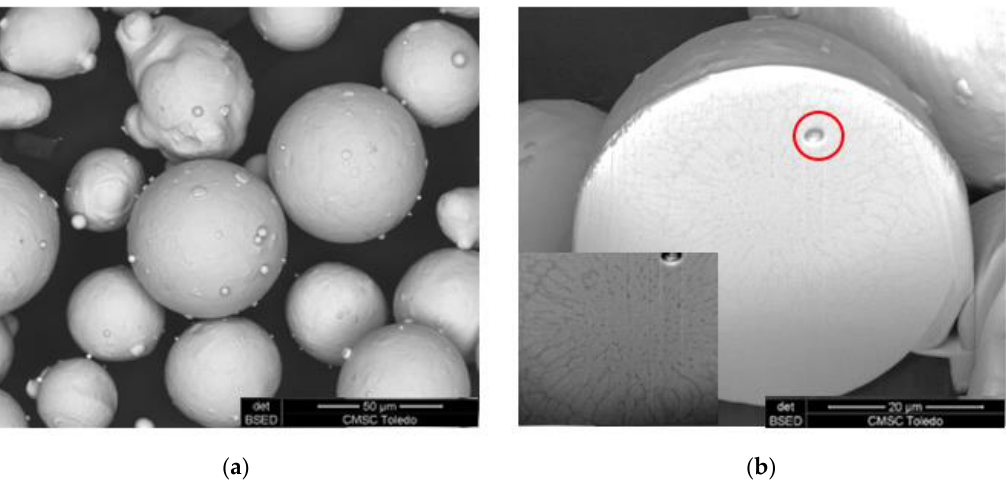
Figure 1. SEM back-scattered electron images of ( a ) powder morphology and ( b ) cross section of one particle cut by FIB and showing an entrapped gas pore. Red arrows indicate micron-sized particles.